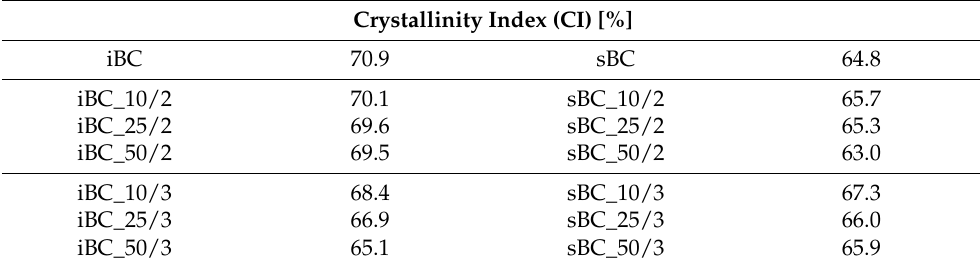
Table 3. Crystallinity index (%) of obtained BC and GO/BC nanocomposites.